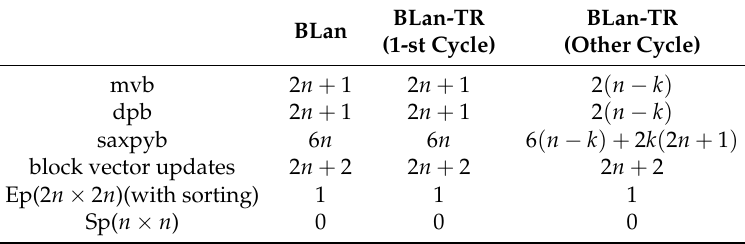
Table 2. Main computational costs per cycle BLan and